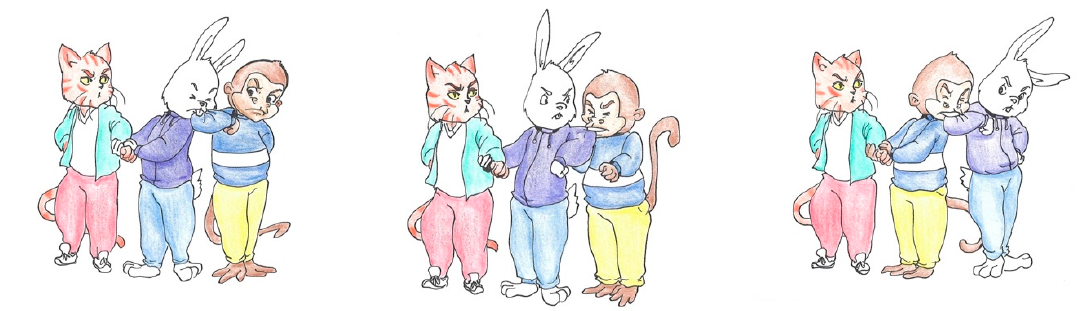
Figure A18. ORC stimulus 3.